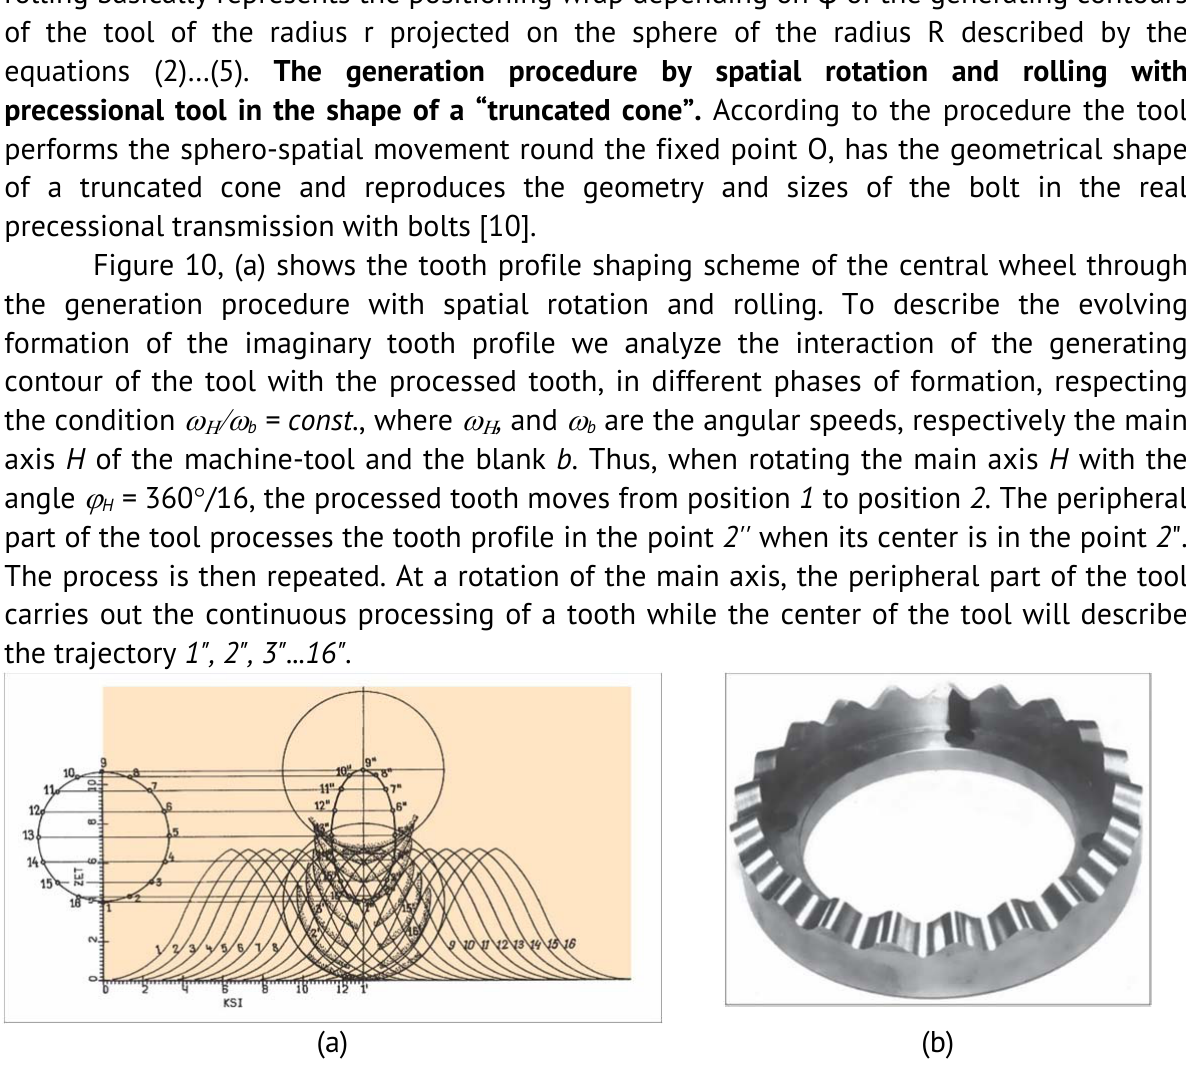
Figure 10 . The position scheme of generation by spatial rotation and rolling of the teeth of conical wheels, with the precessional tool in the shape of truncated cone (a) and samples of manufactured toothed wheels (b, c)